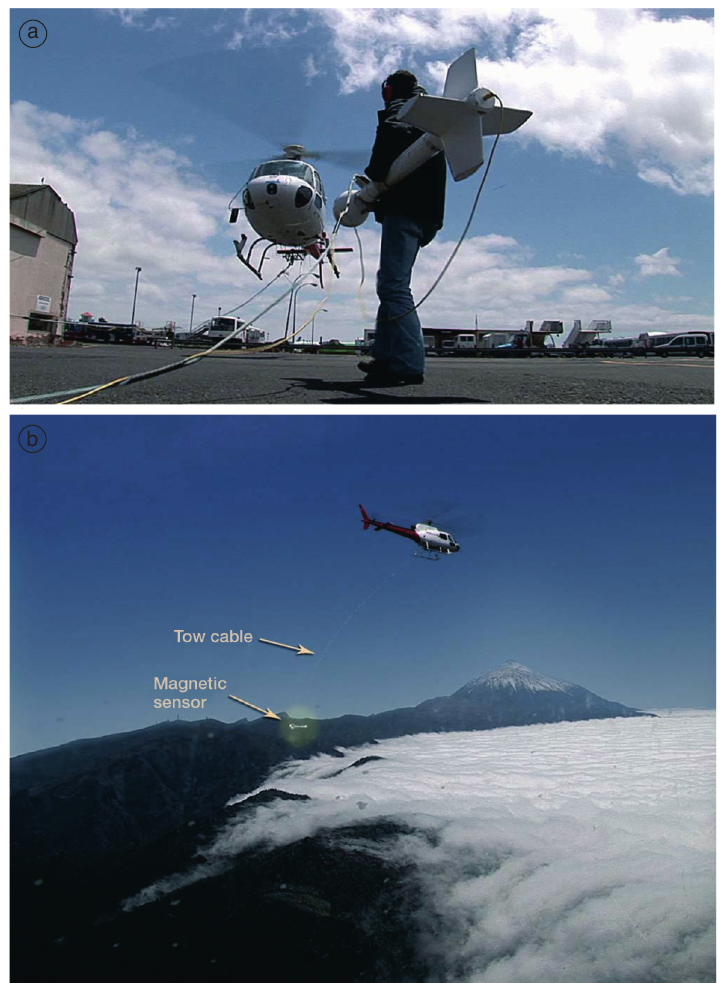
Fig. 2a,b. a) Logistical operations during takoff and landing for launching and retrieving the towed airborne magnetometer bird attached to the barycentre hook of the Aerospatiale Squirrel AS 350 helicopter; b) magnetic sensor and tow cable while airborne with the Teide volcano in the